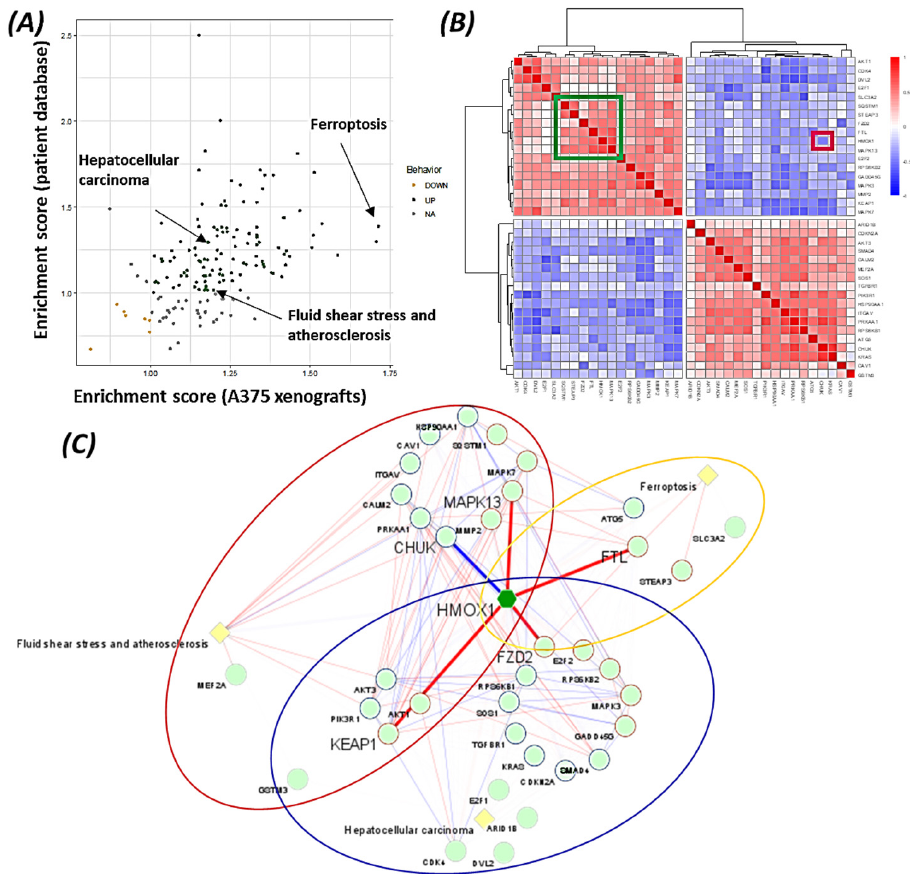
Figure 6. Pathway analysis revealed a key role of HMOX-1 in BRAF inhibitor therapy resistance in the xenograft model and in melanoma patients. ( A ) Dotplot representing the enrichment score obtained for the common pathways identified in the xenograft model and melanoma patients. ( B ) Heatmap representing the correlation matrix between the 36 genes involved in the 3 selected pathways (ferroptosis, fluid shear stress and atherosclerosis, and hepatocellular carcinoma) common in the xenograft model and melanoma patients. Values are from the patient dataset. ( C ) Network representation of the 36 genes (green nodes) involved in the 3 selected pathways (light yellow nodes), with their Spearman correlation as edges. Dark red ellipse, genes belonging to “fluid shear stress and atherosclerosis”; orange, genes belonging to “ferroptosis”; blue ellipse, genes belonging to “hepatocellular carcinoma”; thicker edges, correlation related to HMOX1; blue edges, negative correlation; red edges, positive correlation; edge transparency proportional to correlation value; blue node border, negative correlation with HMOX1; red node border, positive correlation with HMOX1. Correlation values are from the patient